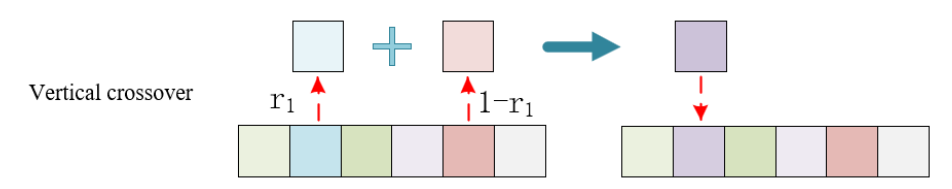
Figure 2. Schematic of vertical crossover.